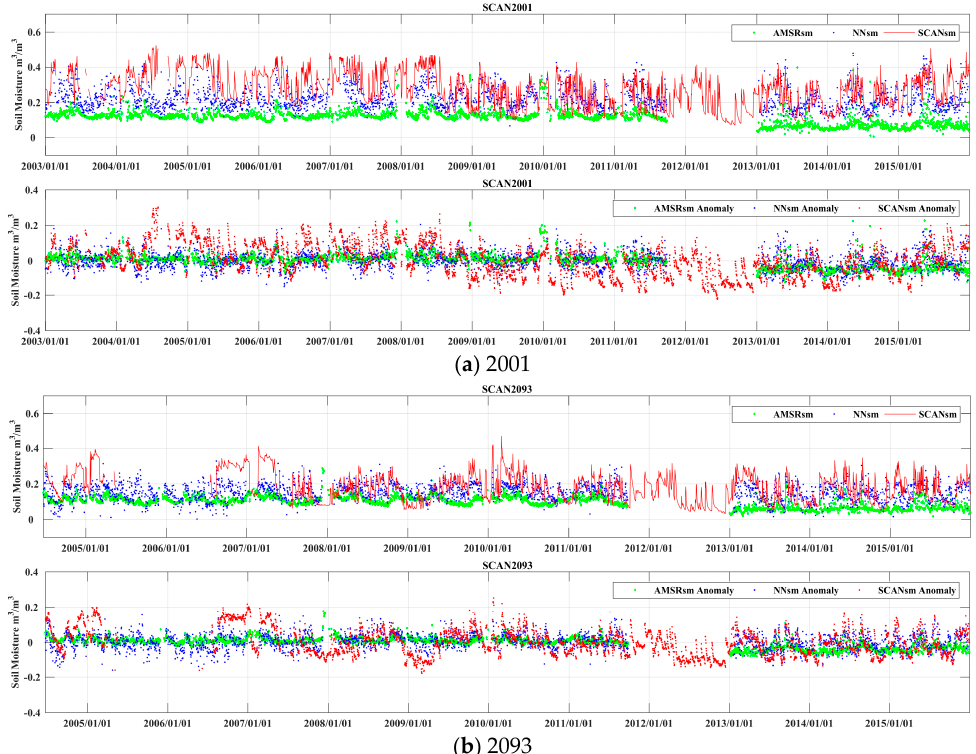
Figure 8. Time series (upper panel) and anomaly time series (lower panel) for SCANsm (red line), NNsm (blue dots) and AMSRsm (green diamonds) over the long time period (2003–2015) in sites: ( a ) 2001 and ( b ) 2093.